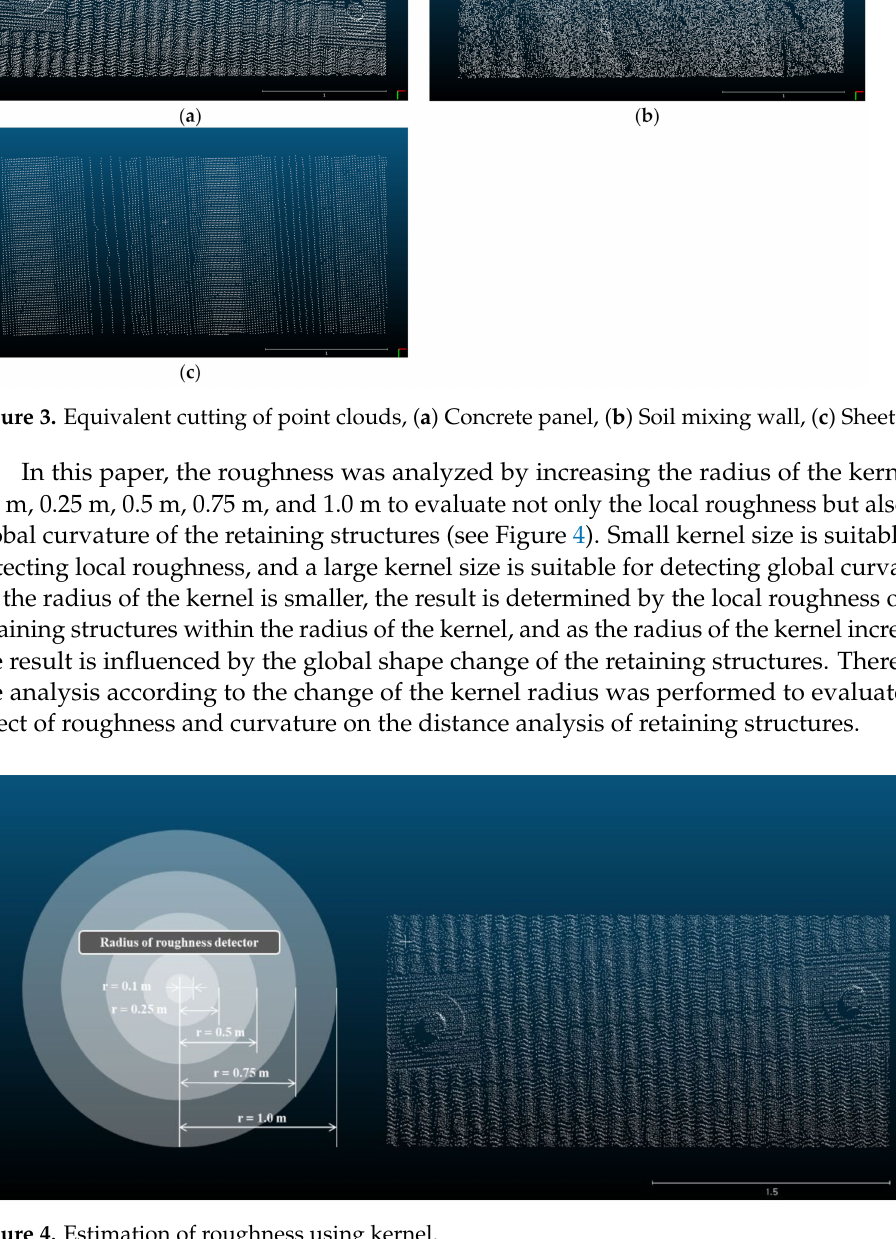
Figure 4. Estimation of roughness using